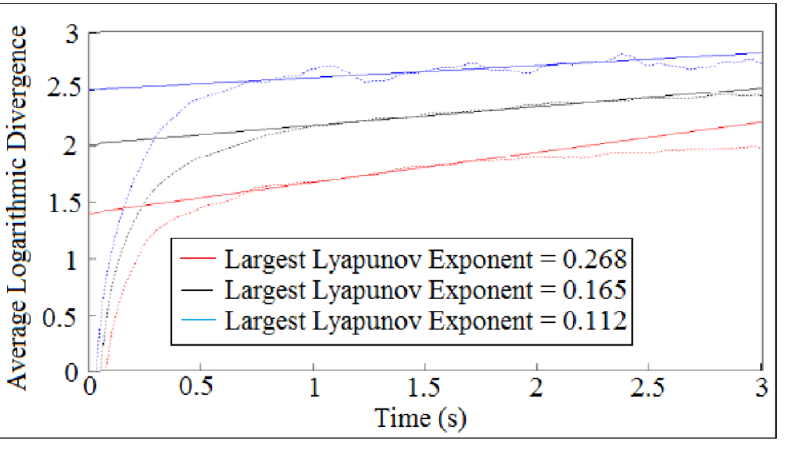
Figure 15. Largest Lyapunov exponent against time for un-stiffened plate, and plate with one and two stiffeners.